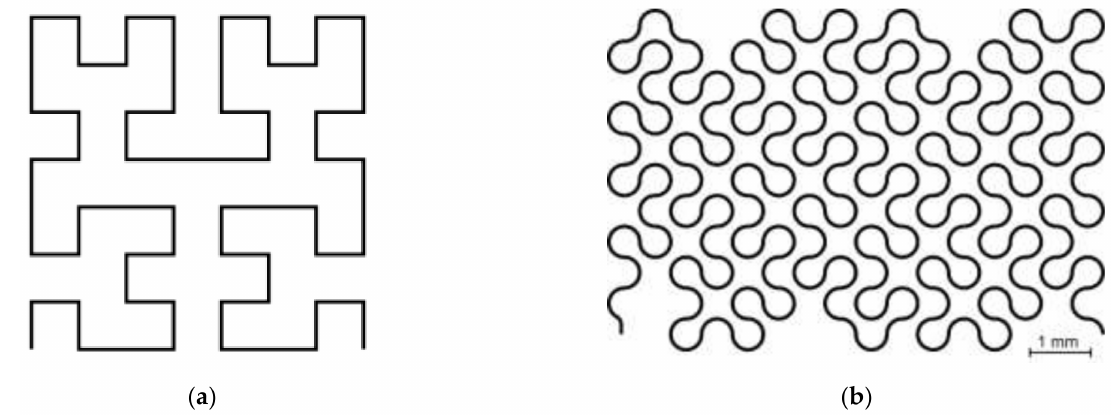
Figure 1. ( a ) Hilbert curve of 2nd order; ( b ) SFC as used in the temperature